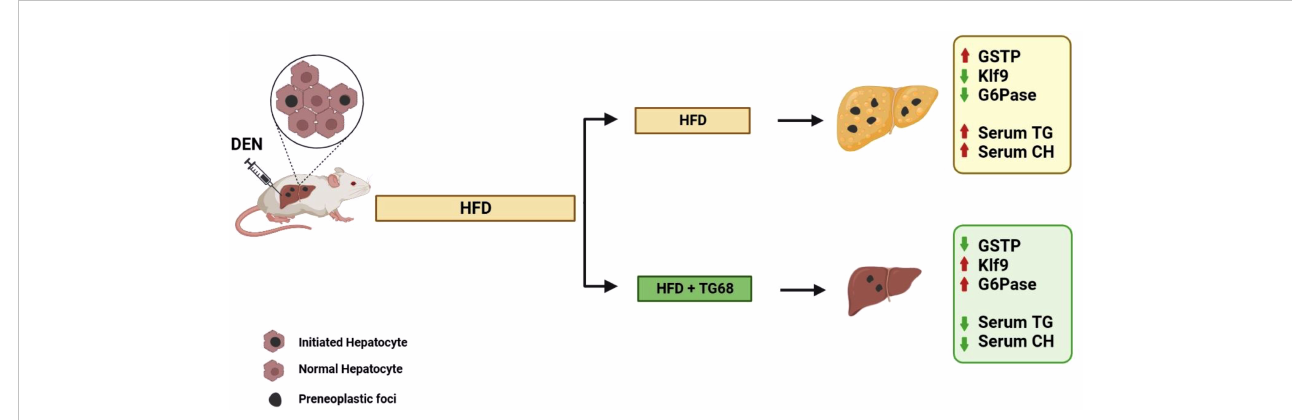
FIGURE 7 A schematic representation of the effect of TG68 on hepatic steatosis and DEN-induced hepatocarcinogenesis. Treatment with TG68 led to a signi fi cant reduction in hepatic steatosis, circulating triglycerides, cholesterol and caused regression of DEN-induced preneoplastic lesions associated with a differentiation program. DEN, Diethylnitrosamine; HFD, High Fat Diet; GSTP, placental form of glutathione-S-transferase; KLF9, Kruppel-like factor 9; G6Pase, Glucose-6-phosphatase; TGs, Triglycerides; CH, Cholesterol. Figure was created with BioRender.com.